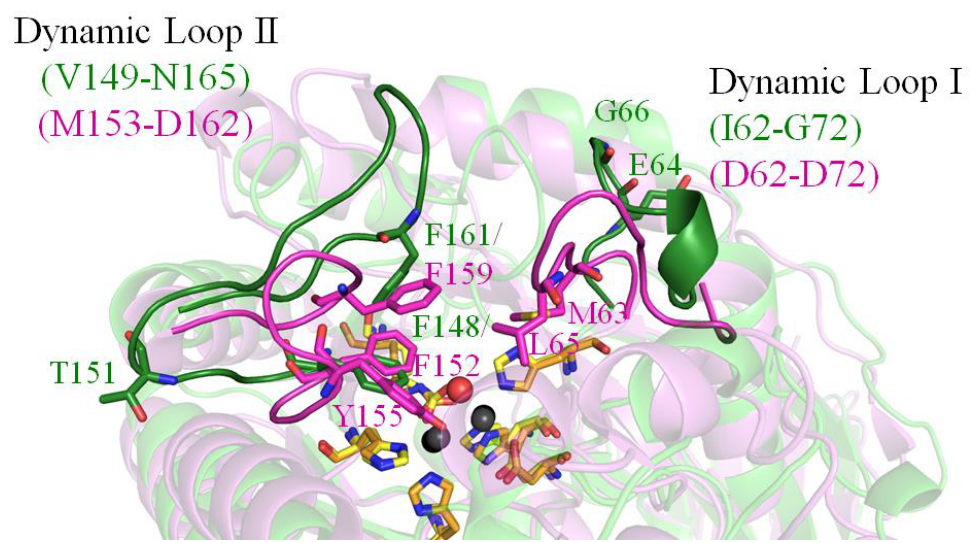
Figure 6. Analysis of substrate binding pockets of HYDase and ALLase. HYDase catalyzing the cleavage of the cyclic amide bond of 5 ′ -monosubstituted hydantoins is widely employed for the commercial production of optically pure D- and L-amino acids for pharmaceutical applications. Like ALLase, HYDase also has two dynamic active site loops crucial for catalysis. The dynamic loop